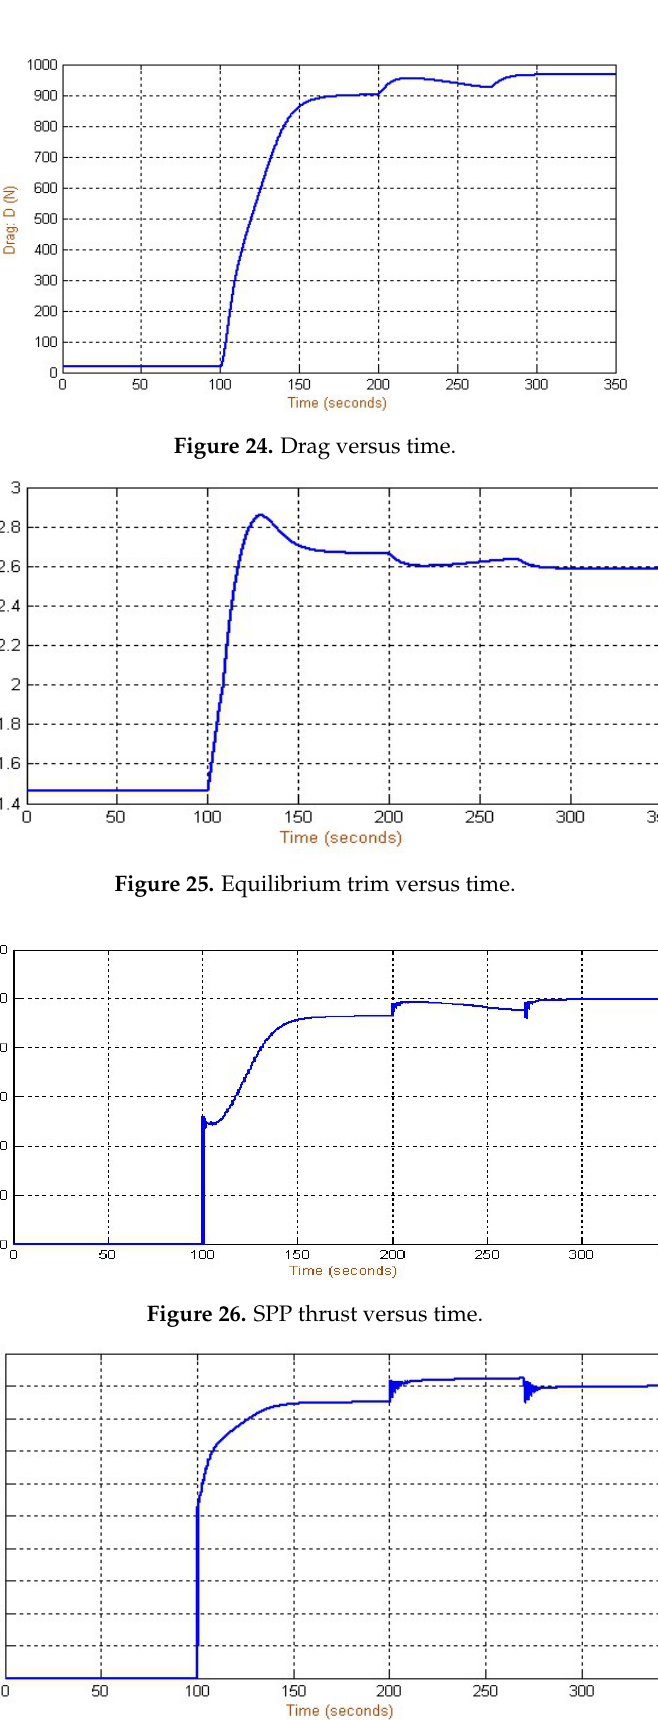
Figure 23. Speed versus time.